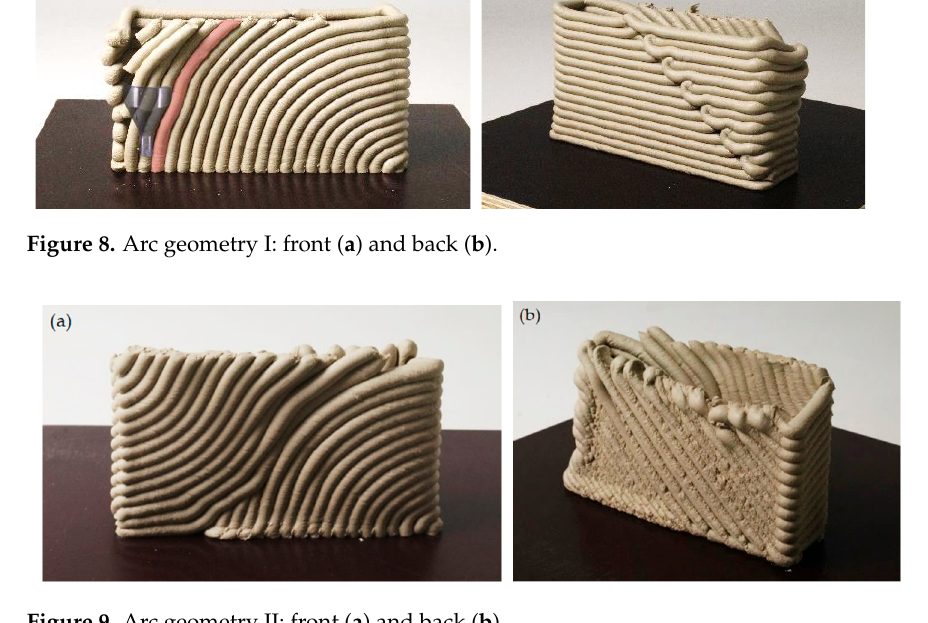
Figure 9. Arc geometry II: front ( a ) and back ( b ). Table 8. Illustration of the path instructions of arc geometry II in the material extrusion path and tool path or movement.